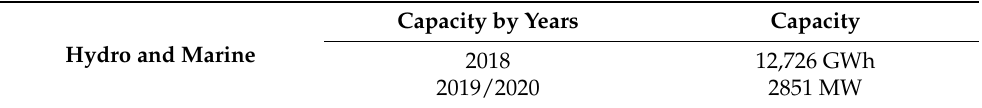
Table 5. Egypt electricity capacity by